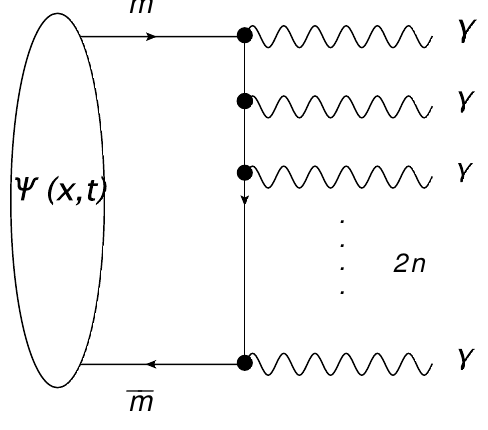
Figure 6. One of the 2 n ! multi-photon emission